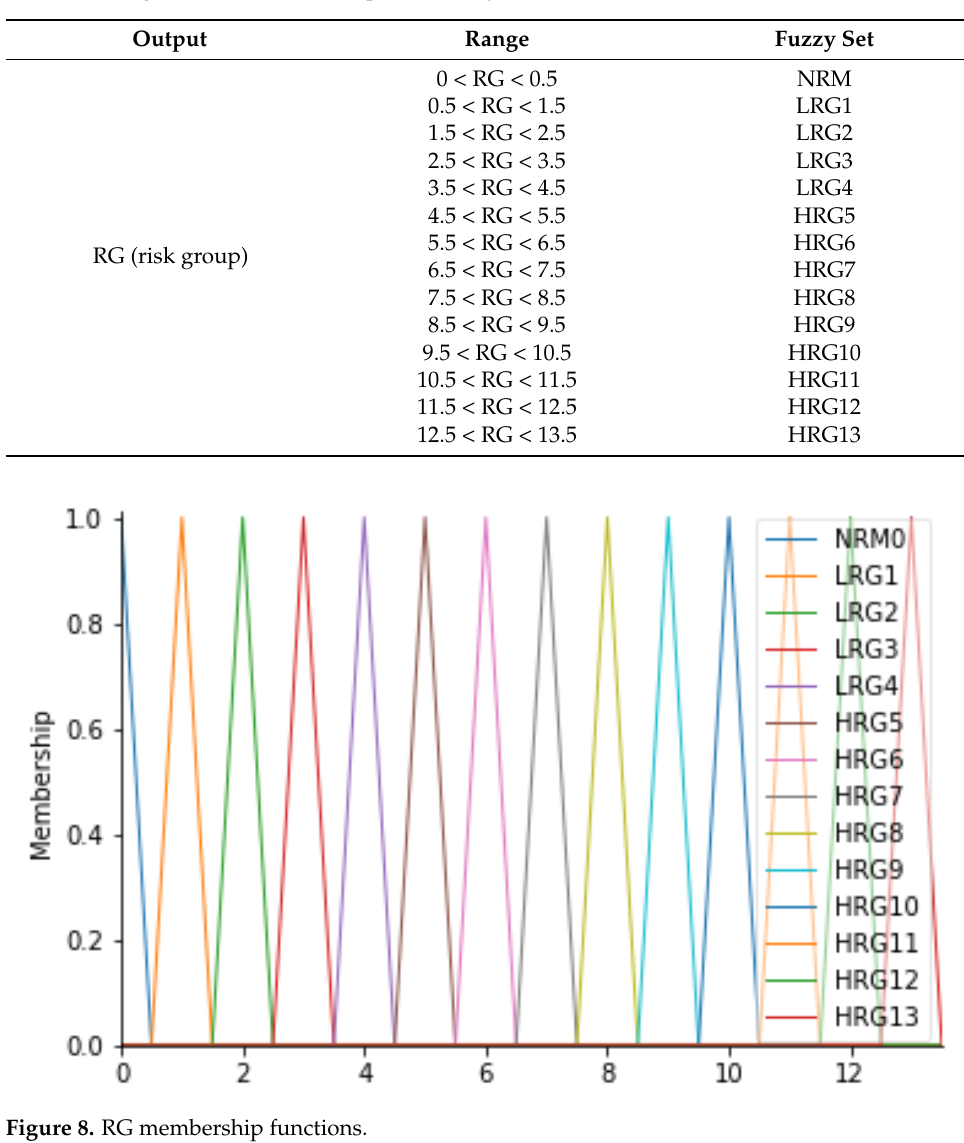
Table 10. Ranges of RG and their respective fuzzy sets.